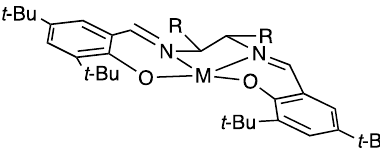
Figure 50. The stepped conformation of a metal–salen complex.